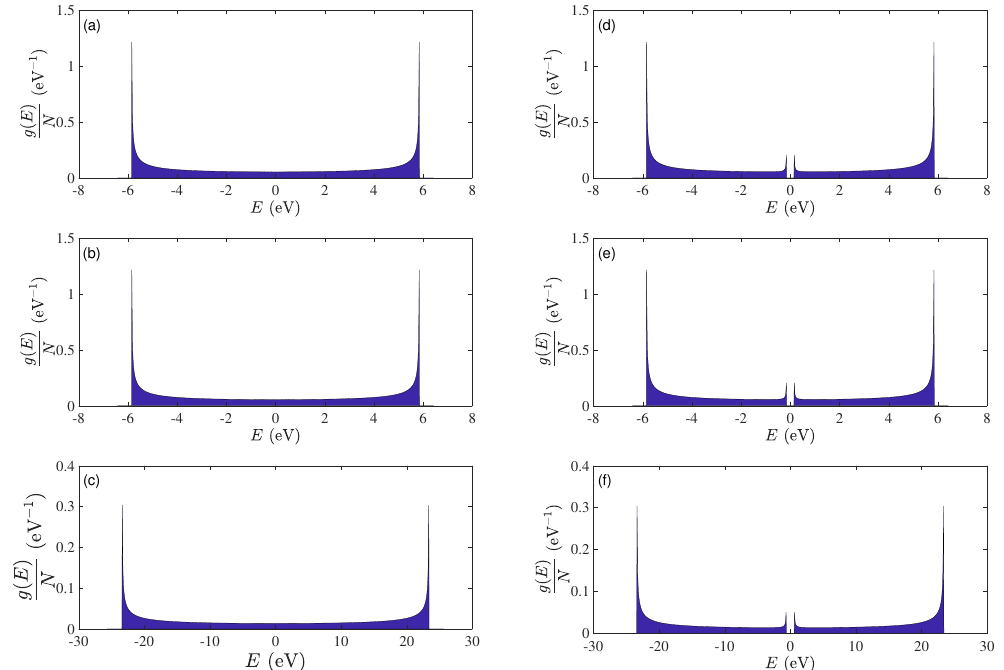
Figure 10. Density of states, g ( E ) , per number of carbon atoms, N , for the three Tight-Binding (TB) variants used in this work. ( a ) cumulenic TBI, ( b ) cumulenic TBImod, ( c ) cumulenic TBImodt4times, ( d ) polyynic TBI, ( e ) polyynic TBImod, ( f ) polyynic